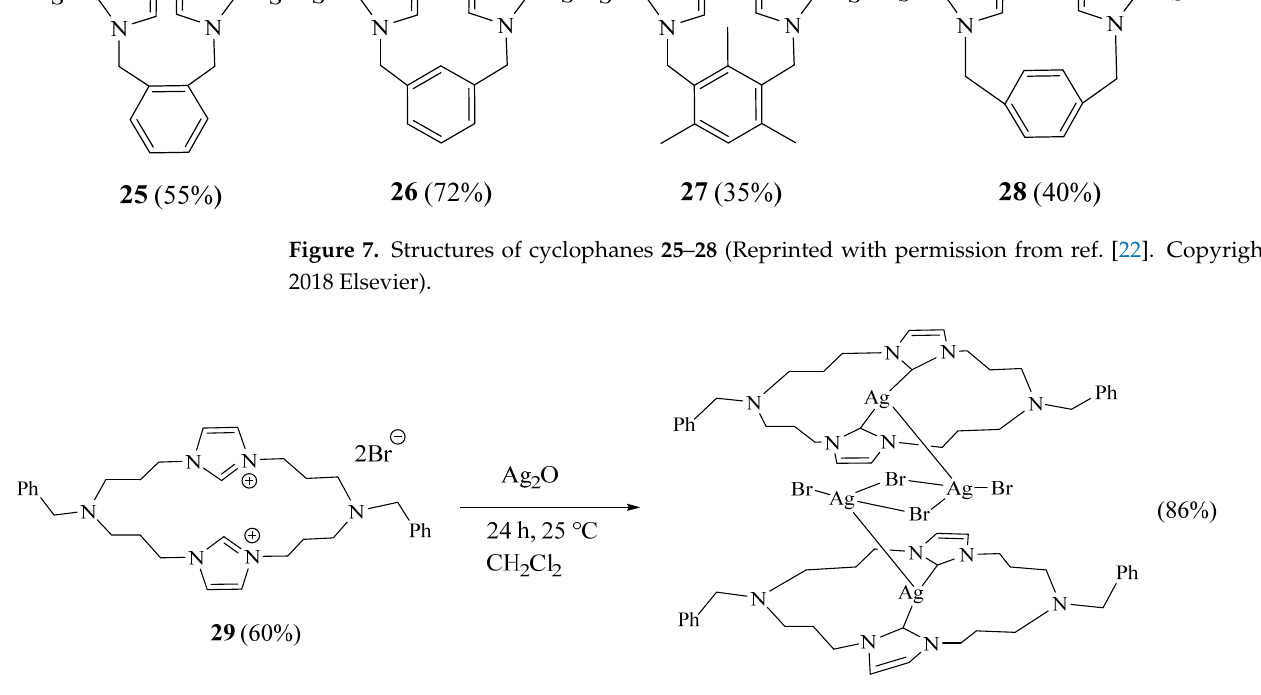
Figure 7. Structures of cyclophanes 25 − 28. (Reprinted with permission from ref. [22]. Copyright 2018 Elsevier).